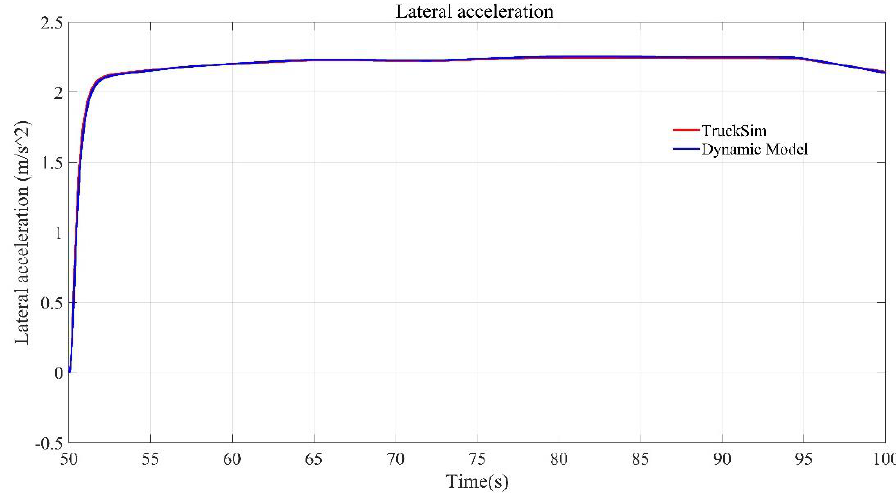
Figure 16. Comparison of the lateral acceleration output by the dynamics model using estimation results and TruckSim model.